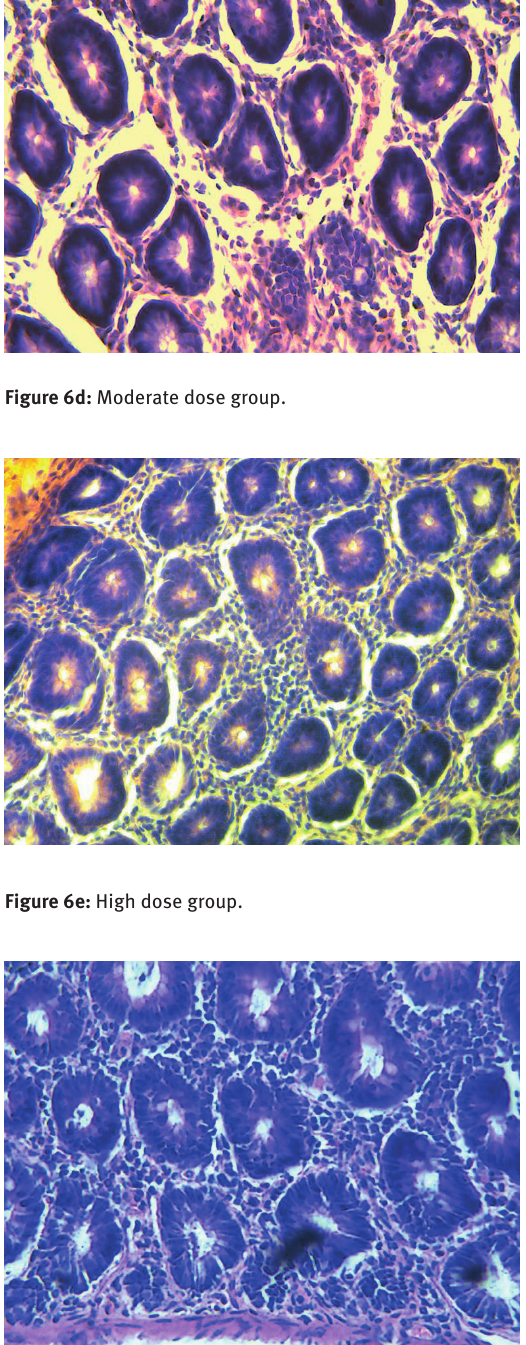
6f Low dose group Figure 6f: Low dose